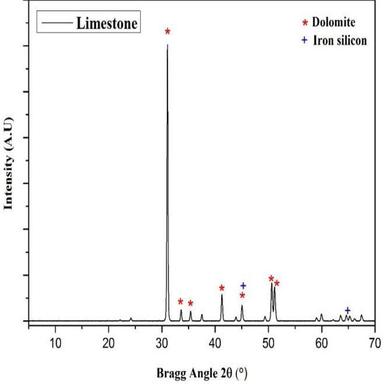
Experimental X-ray powder diffraction profile of LIM at room temperature.